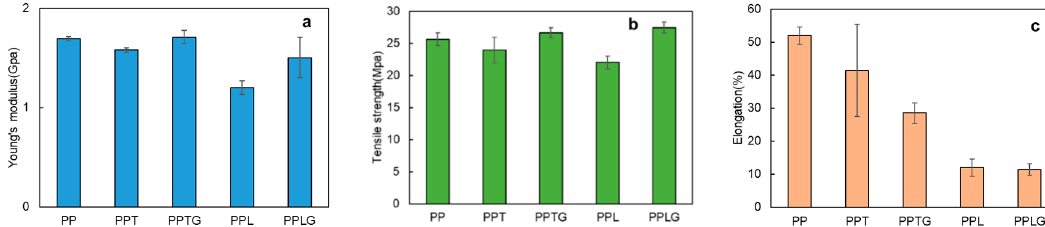
Figure 2. The tensile property of pure polypropylene (PP), PP / polyphenol blends, and PP / crosslinked polyphenol blends: ( a ) Young’s modulus; ( b ) Tensile strength; ( c ) Elongation.